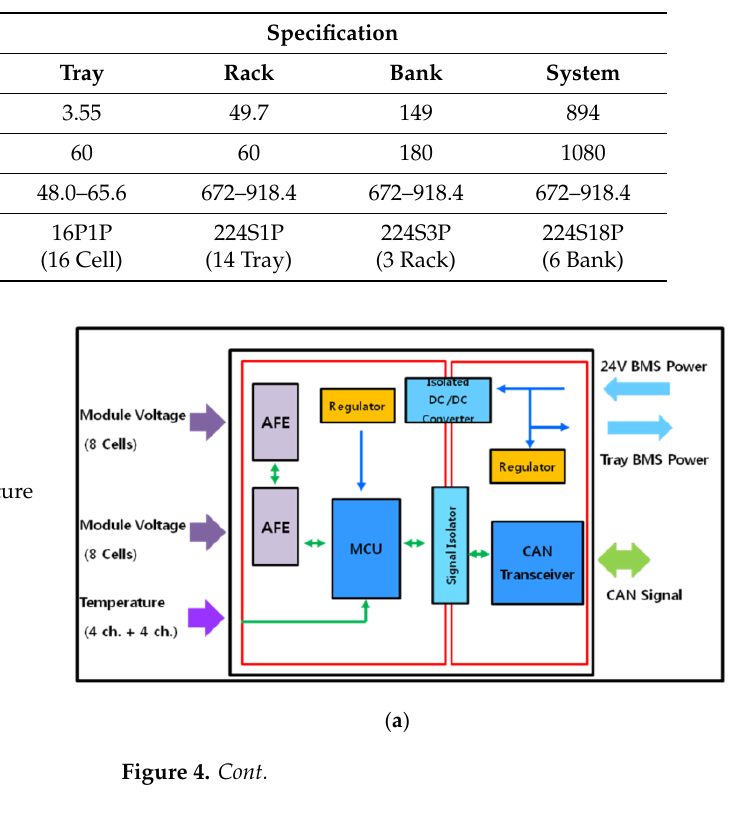
Table 1. Specifications by Battery Configuration.